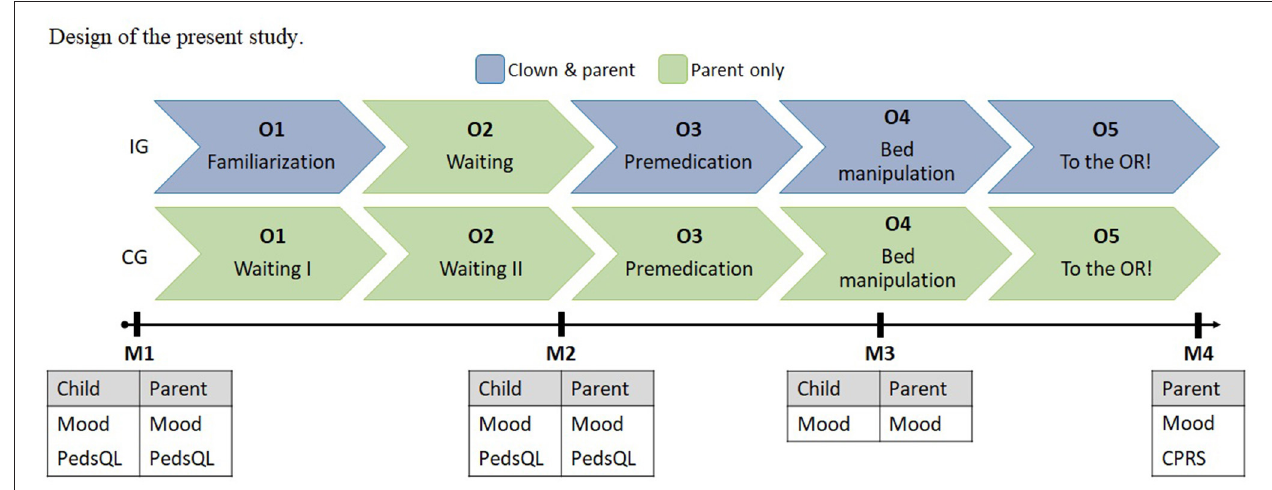
FIGURE 1 | Design of the present